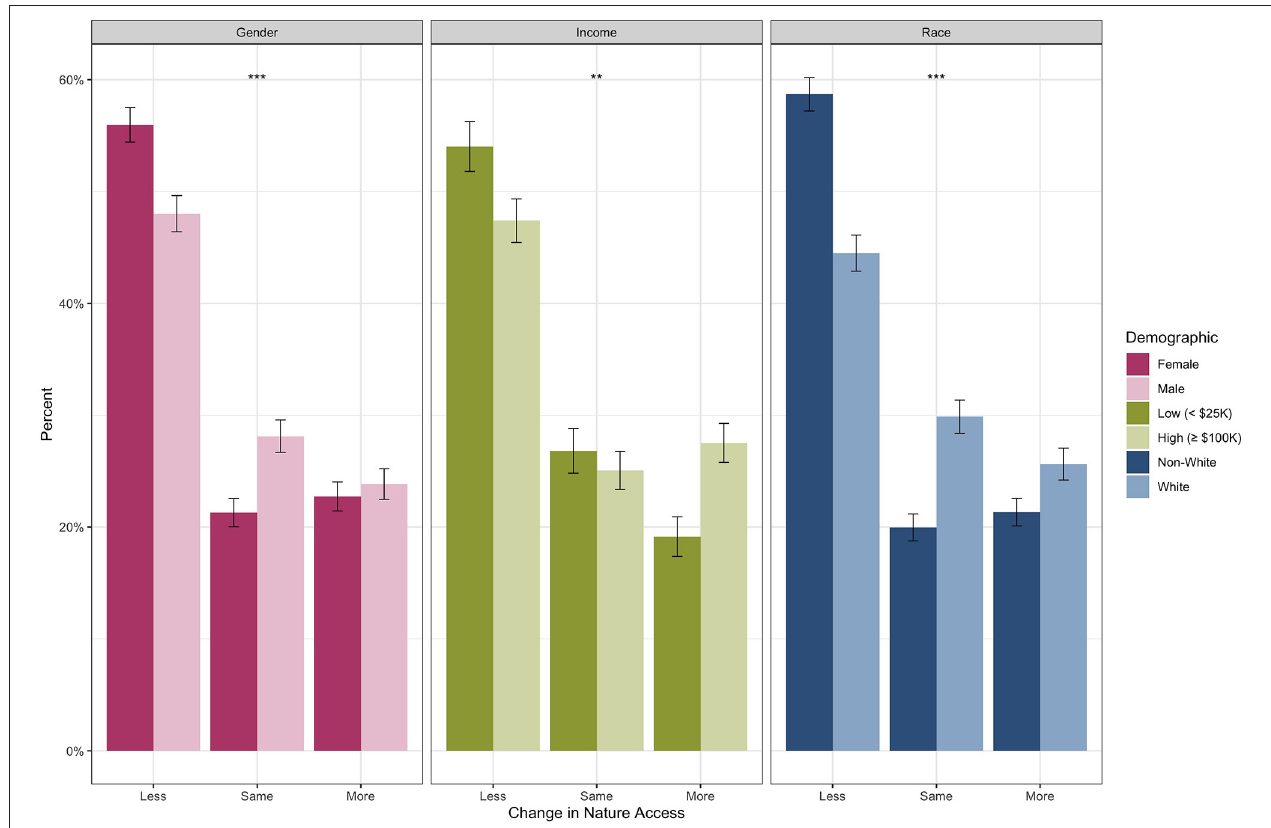
FIGURE 2 | Changes in time spent in nature during the pandemic by demographic group. Error bars represent SE of mean. Significance is from chi-squared tests within demographic groups. ** p < 0.01, *** p < 0.001.